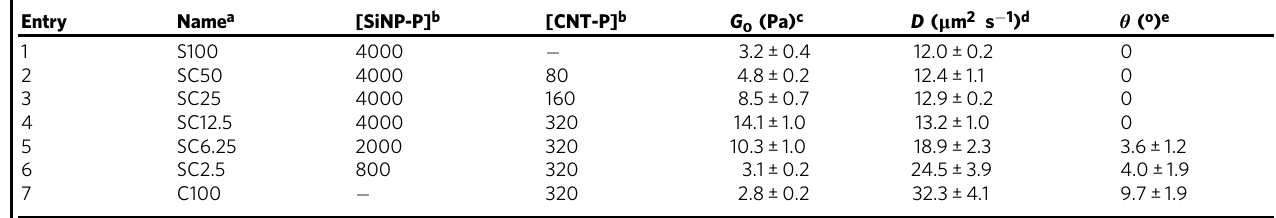
Table 1 Overview on binary and ternary SiNP/CNT-DNA nanocomposite materials. Entry